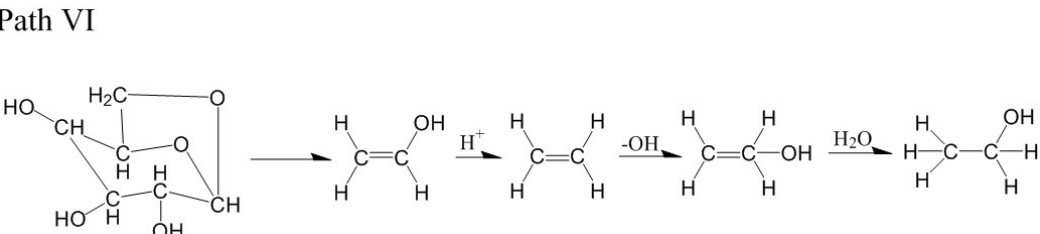
Figure 22. Relevant path VI of ethanol generation at 3000 K.